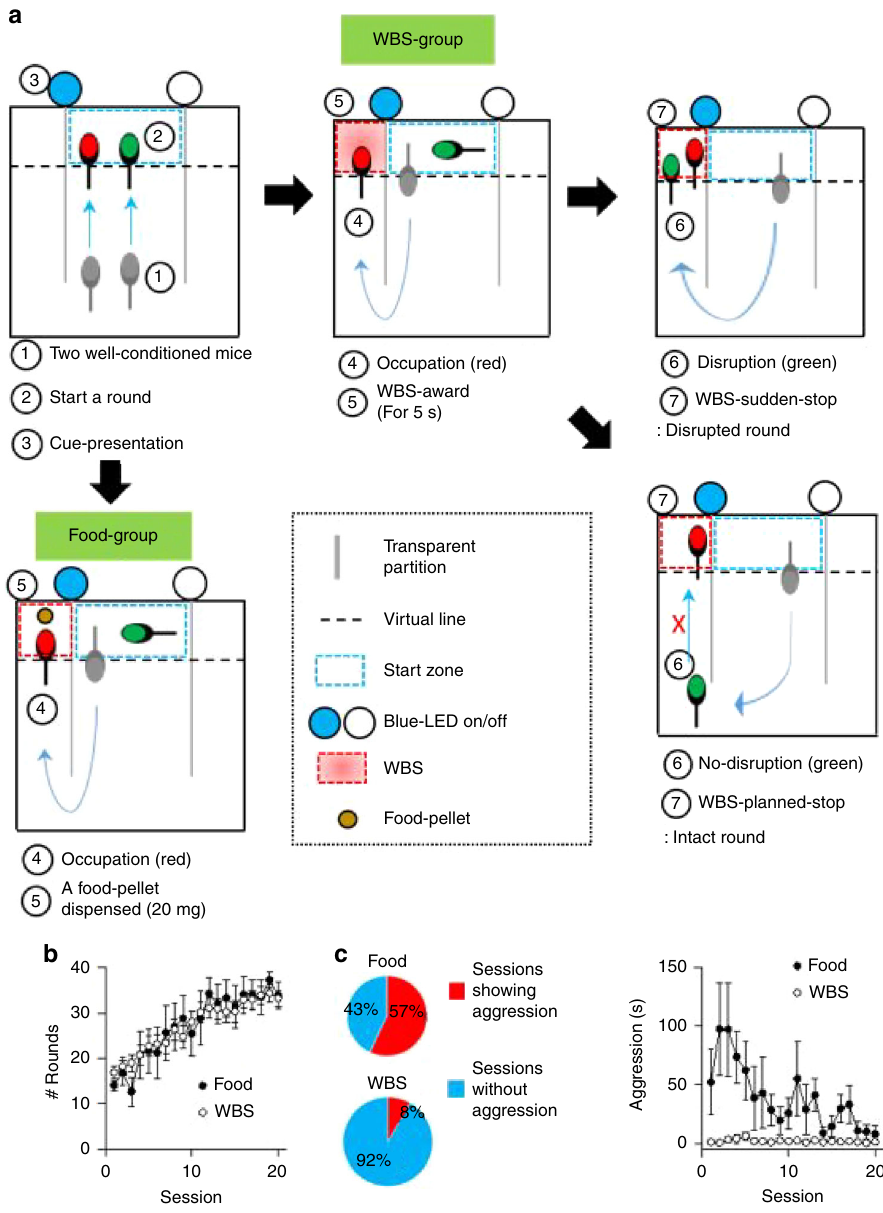
Fig. 2 Less aggressive behavior in the WBS condition during the con fl ict resolution test. a Scheme of the con fl ict resolution test. A round was initiated when two well-conditioned mice entered the start-zone. Reward was provided when any mouse reached the zone denoted as the one with reward fi rst. b The number of rounds increased over time in both conditions (Two-way RM analysis of variance (ANOVA), session, F 19, 418 = 19.3, P < 0.001). c Mice in the WBS condition showed less aggression while mice in the food condition exhibited prominent aggression (two-way RM ANOVA, group X session, F 19, 418 = 8.1, P <